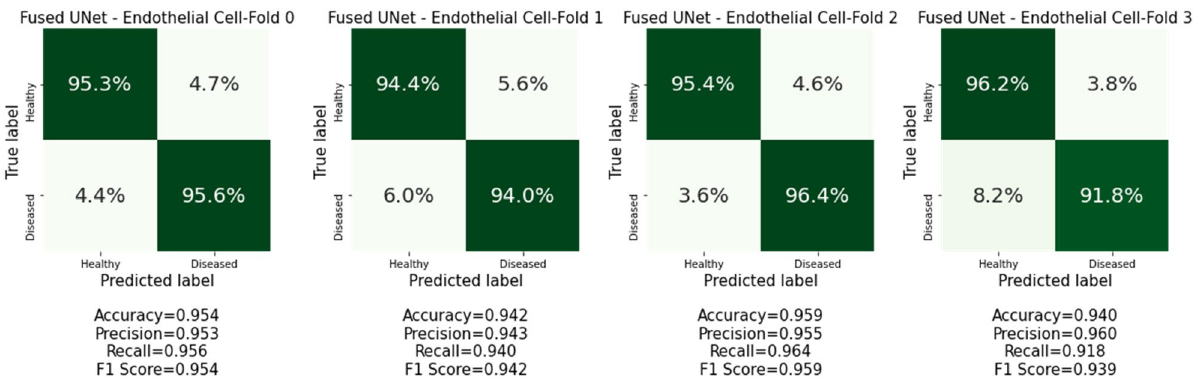
Figure 6. Confusion matrices from cross-validation experiments on the LEC cells characterization